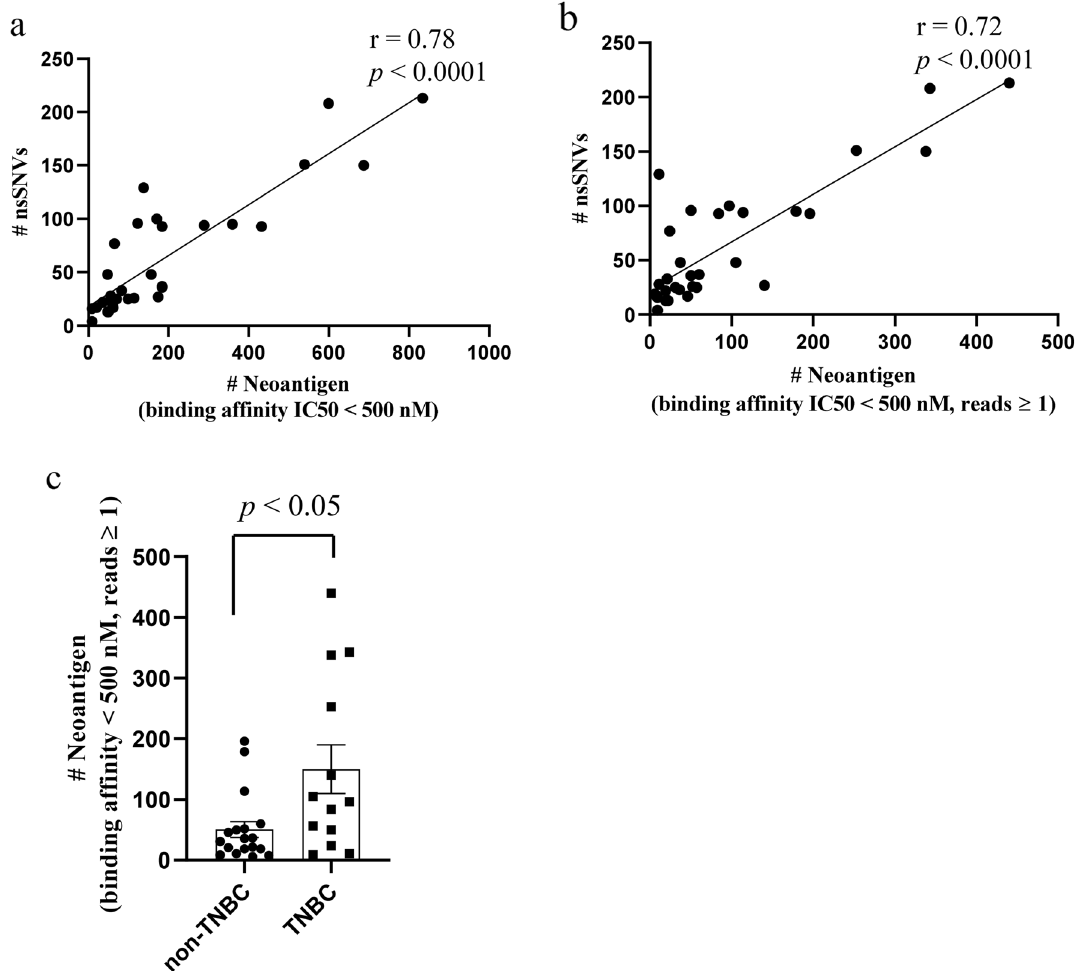
the number of nsSNVs (r = 0.78, p < 0.0001). ( b ) The number of predicted neoantigens (IC50 < 500 nM, read count ≥ 1) was highly correlated to the number of nsSNVs (r = 0.72, p < 0.0001). ( c ) The number of